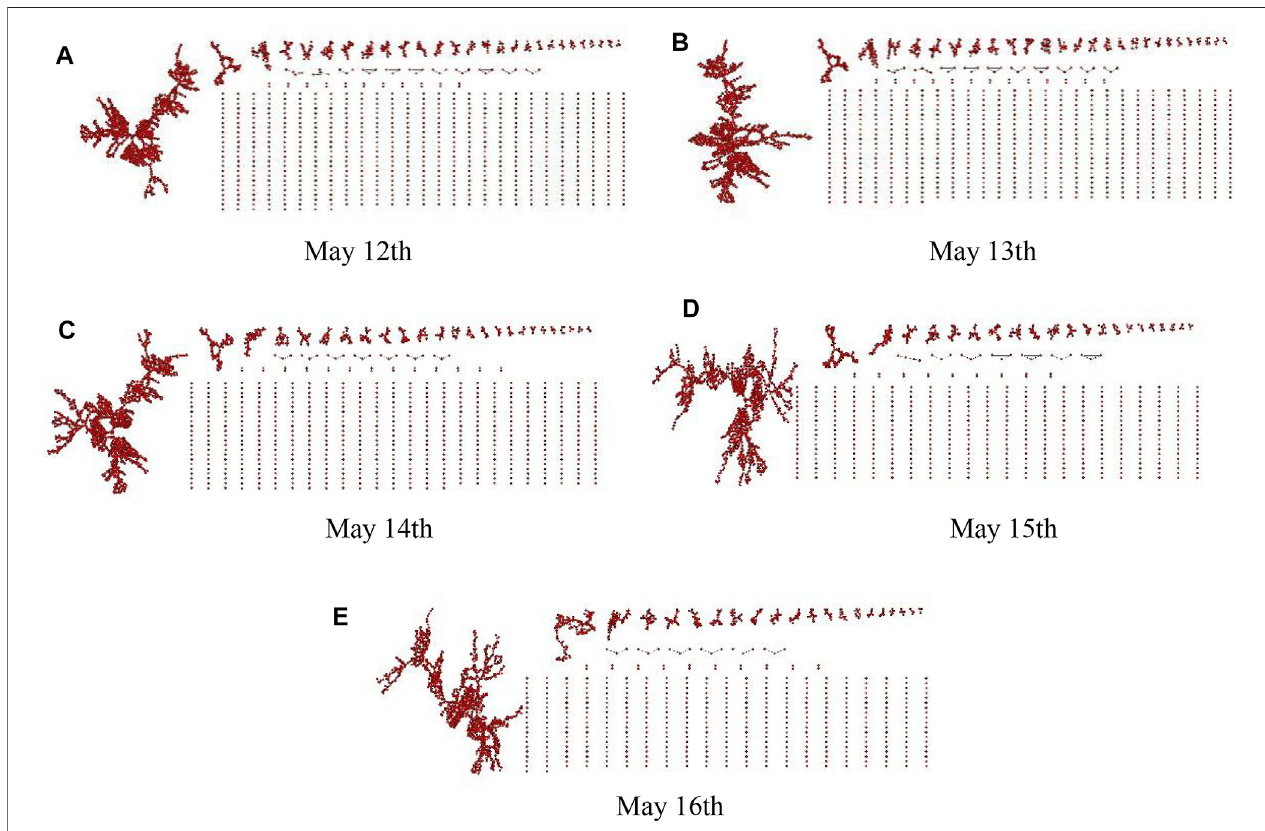
FIGURE 8 | Road network model during the golden